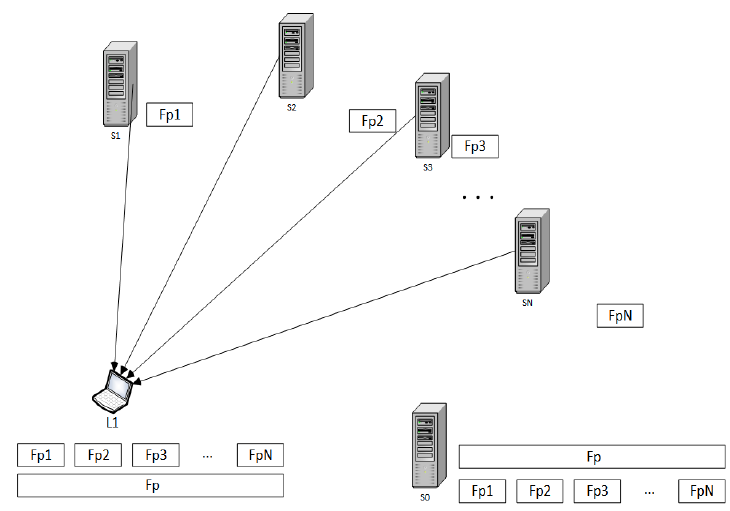
Figure 5. Details of file fragment